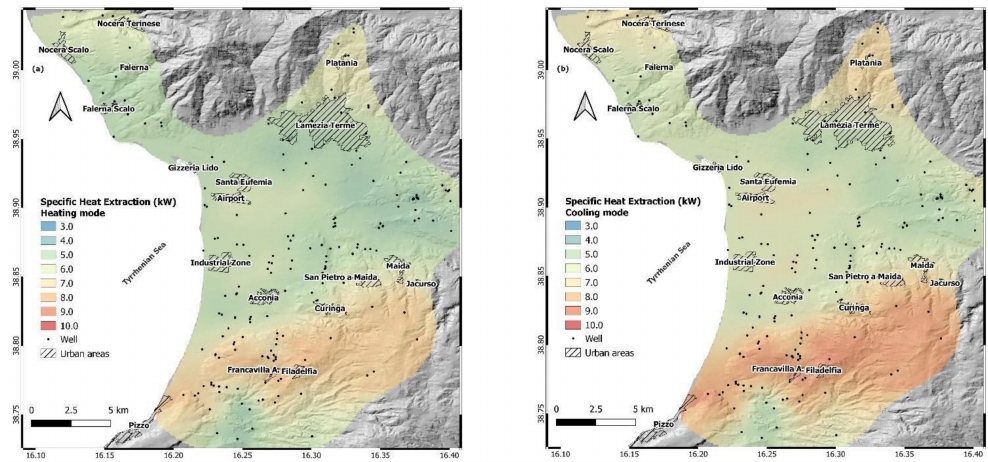
Figure 4. Maps of the estimated specific heat extraction for ( a ) heating and ( b ) cooling for 100 m depth boreholes in the SEP.